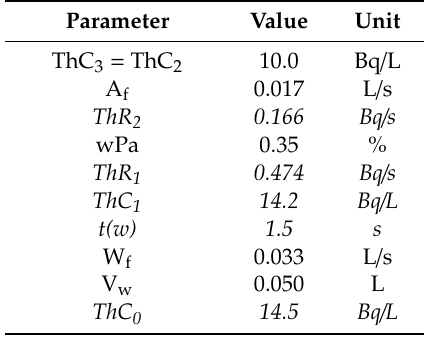
Table 1. Exemplary observed experimental values for calculating the thoron concentration in the water at the sampling point (ThC 0 ) based on the detector reading (ThC 3 ) and specific setup parameters. All calculated parameters are shown in